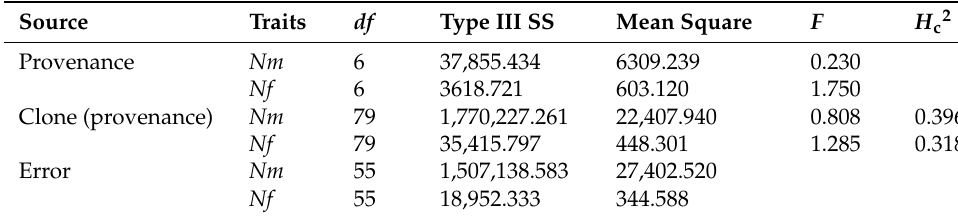
Table 2. GLM-based ANOVA for flower number in the